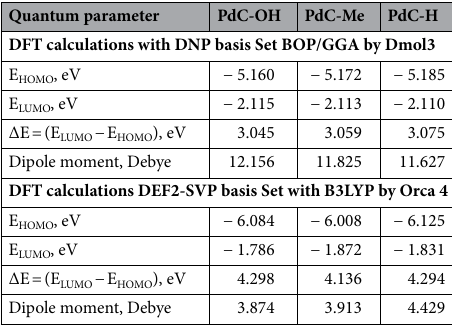
Table 10. Quantum parameters of the investigated compounds at DFT level using Dmol3 and